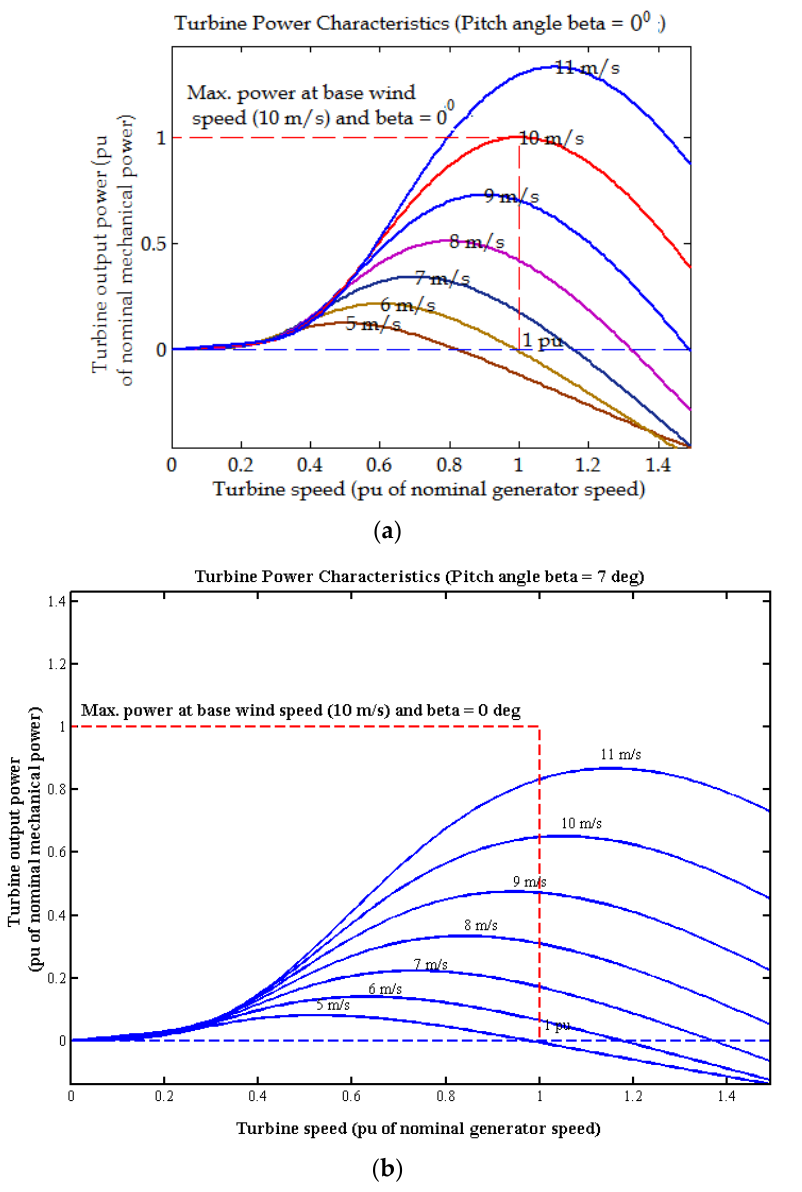
Figure 1. ( a ) Turbine output power Vs turbine speed when the pitch angle is zero-degree. ( b ) Turbine output power Vs turbine speed when the pitch angle is 7 degrees.